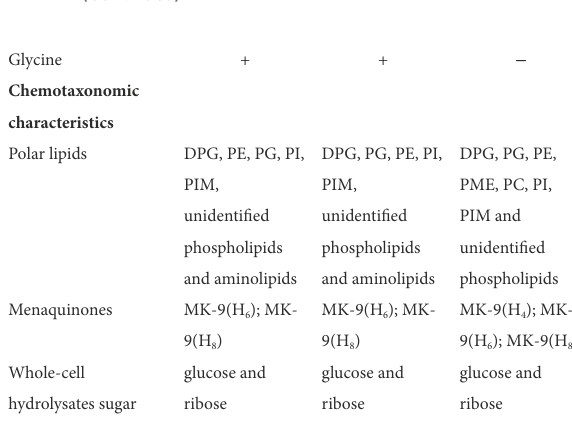
TABLE 1 Physiological and biochemical properties among species Streptomyces sp.